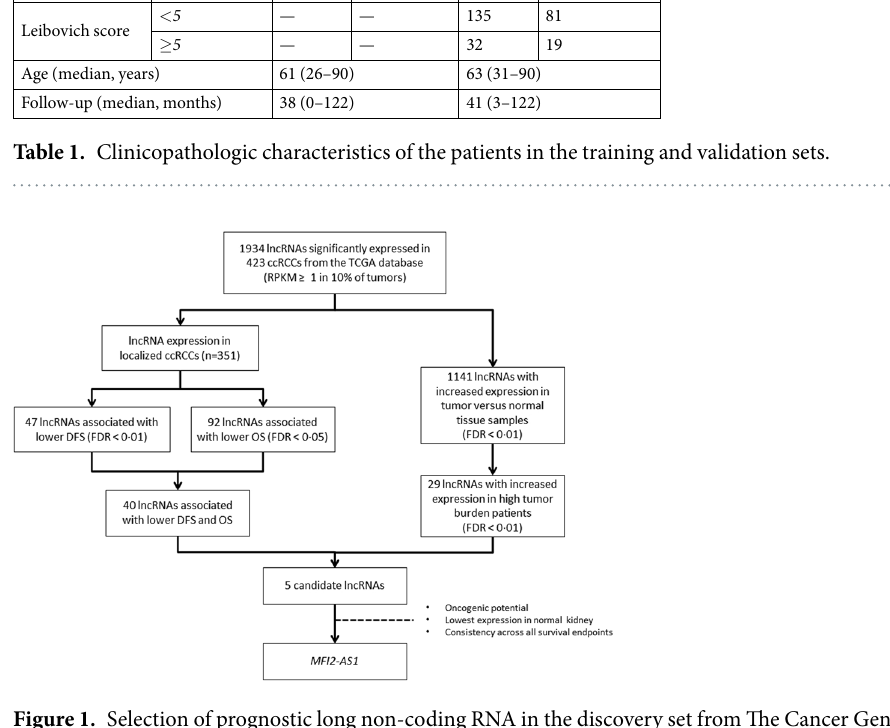
Figure 1. Selection of prognostic long non-coding RNA in the discovery set from The Cancer Genome